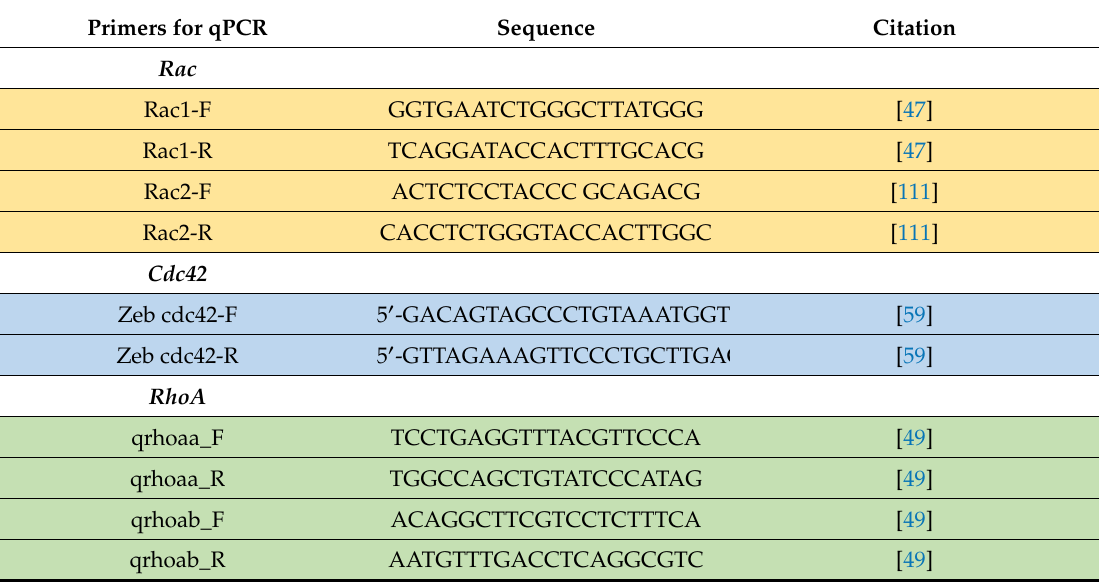
Table 5. Designed primers to study Rho GTPases expression in